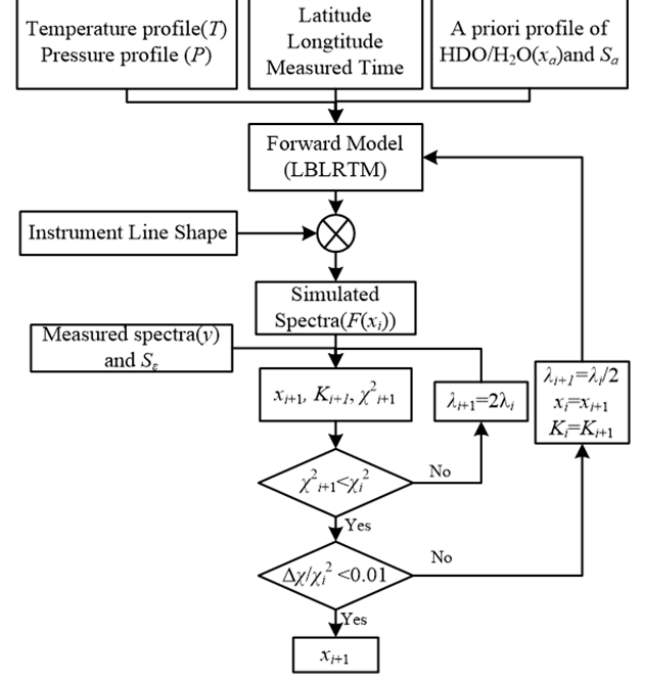
Figure 5. The flow chart of retrieval method.